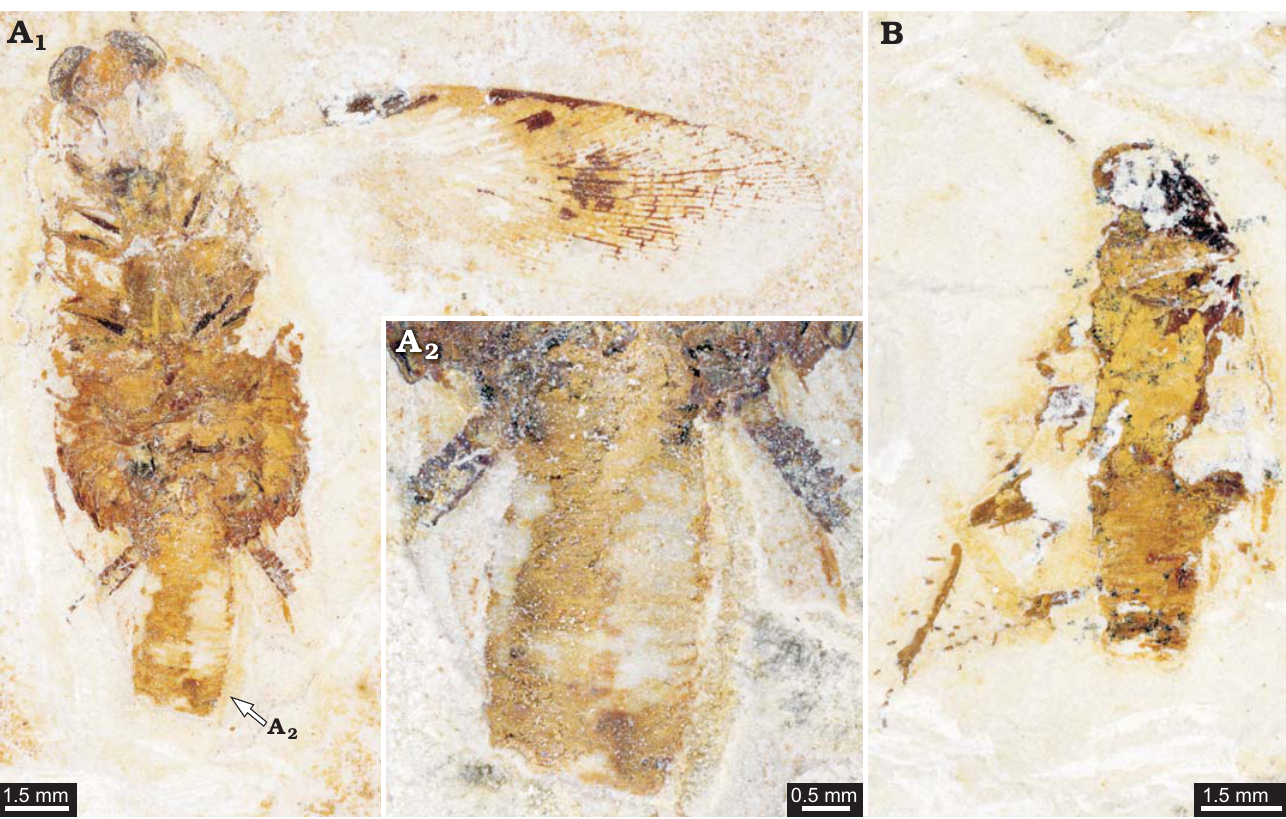
Fig. 16. Cockroaches with oothecae from the Aptian, Cretaceous Crato Formation of Brazil. A . AI 3208, “ Mesoblattina ” cf. limai Pinto and Purper, 1986. Overview (A 1 ), close-up of ootheca (A 2 ). B . Undescribed cockroach AI 292 (from Hörnig et al. 2013: fig.